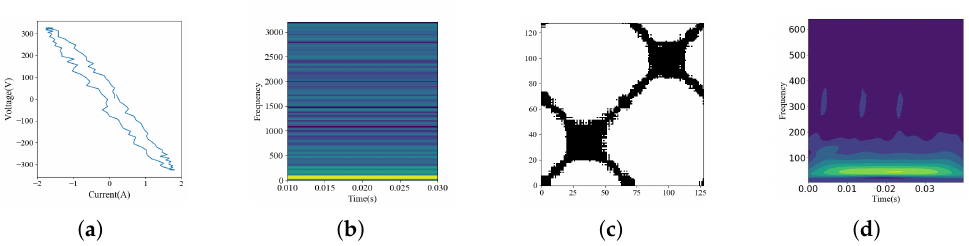
Figure 1. Different types of load map features. ( a ) V-I trajectory. ( b ) Spectrogram. ( c ) Recurrence plot. ( d ) Continue wavelet